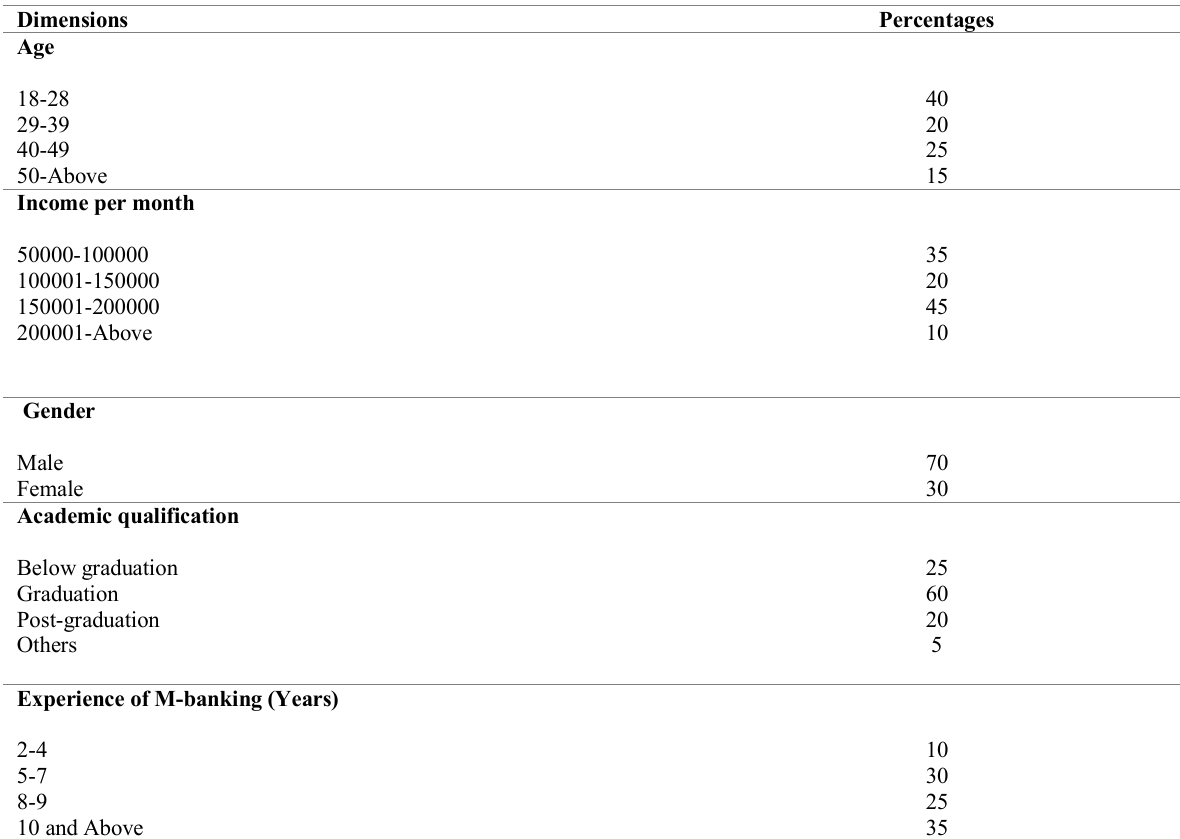
Table 1: Descriptive statistics of the participants ( N=380